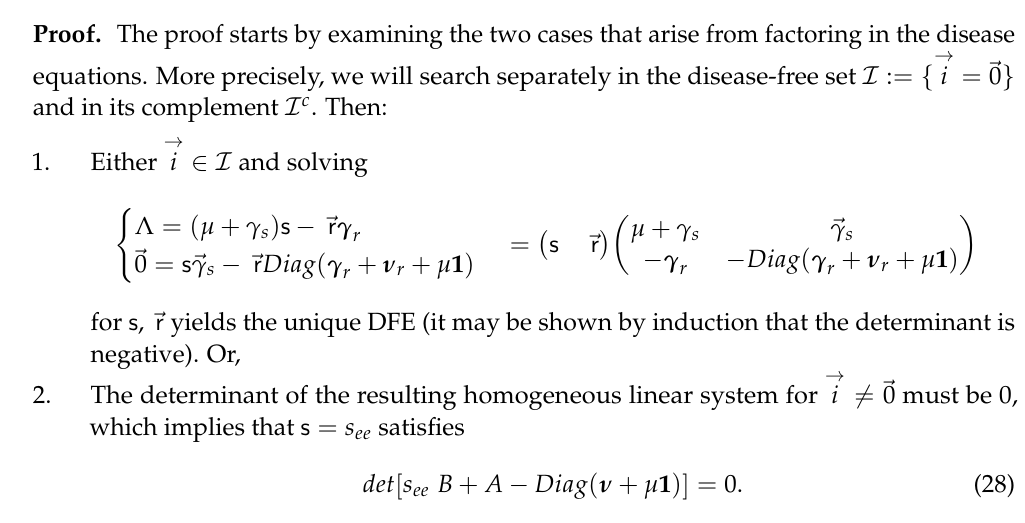
Figure 3. Stream plots of ( s , i ) for an example of a SIRS-FA model with one infectious class, when γ s ∈ { 1/100,3 } is smaller and bigger, respectively, than the critical vaccination γ ∗ s = 0.239087 defined in